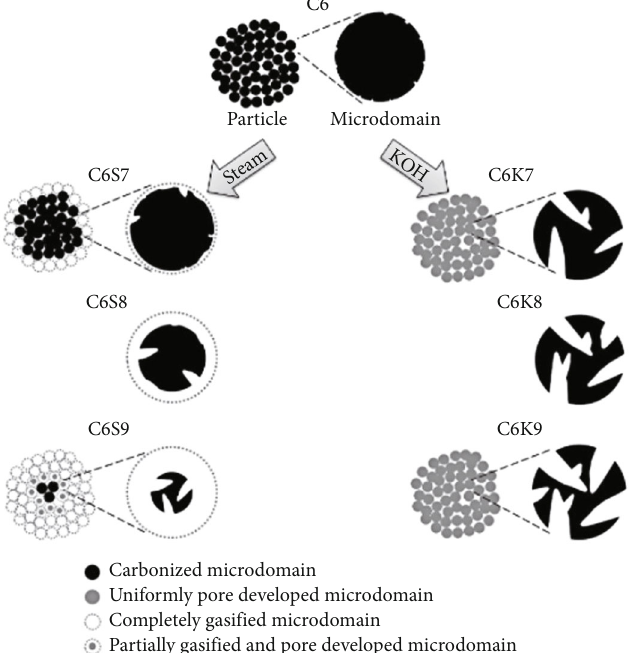
Figure 1: Di ff erences between AC prepared from steam activation (C6S9) and KOH activation (C6K9), respectively, explained in terms of microstructure model